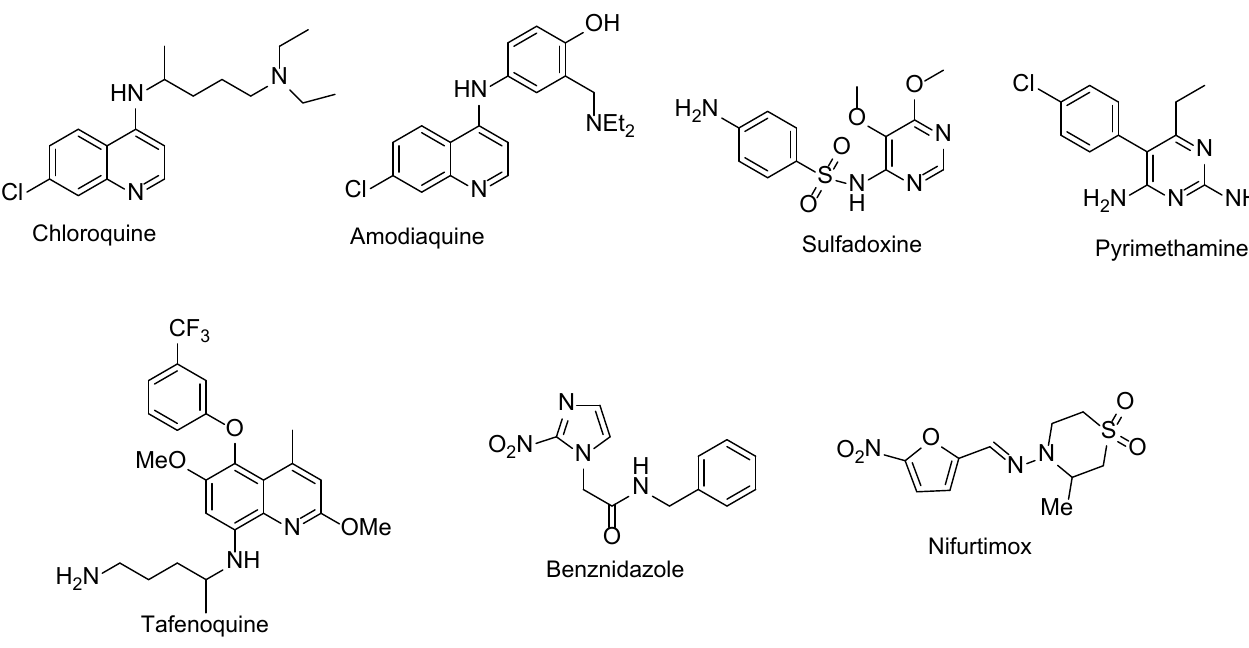
FIGURE 1 - FDA-approved antiparasitic drugs available to treat Chagas and malaria